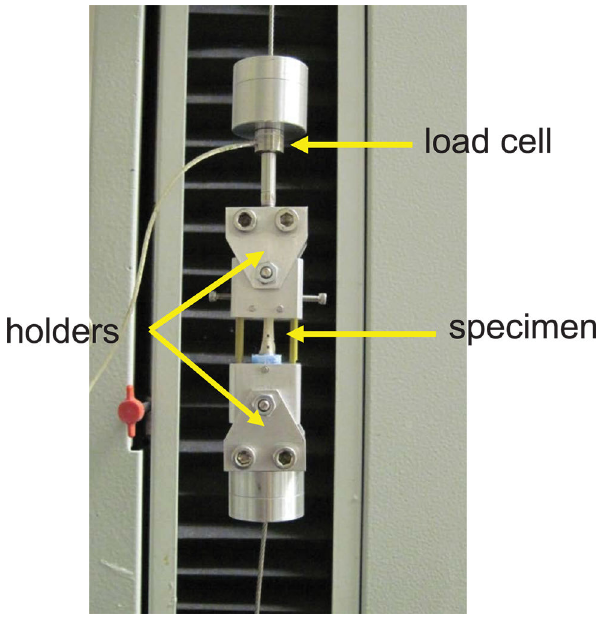
Figure 2. An illustration of the tensile testing